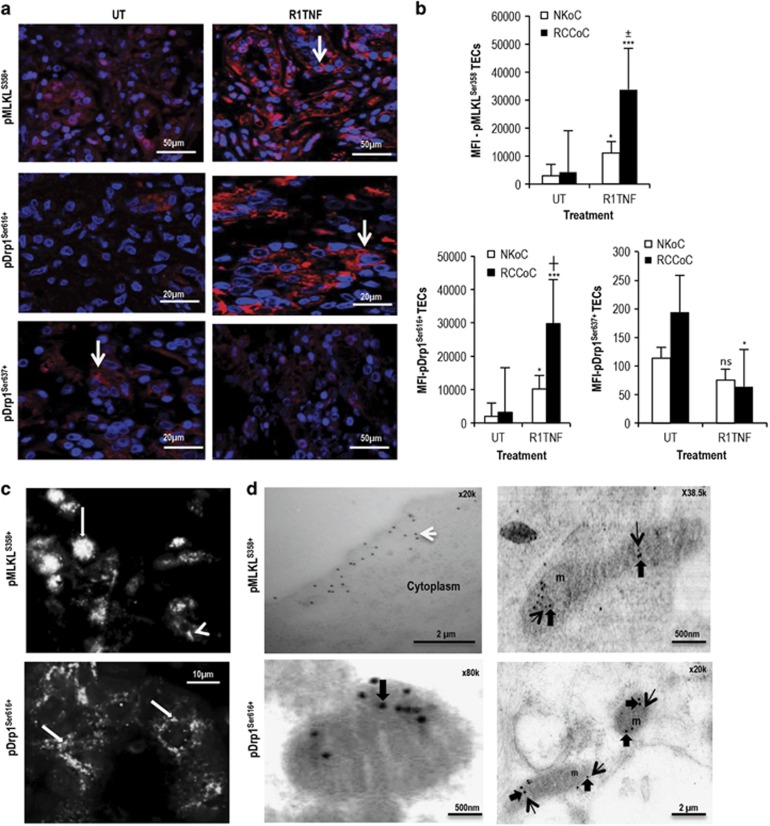
Effect of R1TNF on pMLKLSer358, pDrp1Ser616 and pDrp1Ser637 expression in organ cultures of RCC grade 1 and adjacent non-tumor kidney (NK). (a) R1TNF induced a marked expression of pMLKLS358 and pDrp1Ser616 but a reduced signal for pDrp1Ser637 compared with untreated controls (UT), with signal mainly confined to mTECs (arrows). (b) Quantification of the phosphorylated proteins in normal and mTECs presented as mean fluorescent intensity (MFI) shows a statistical significant difference between cultures. ***P<0.001 versus UT, *P<0.05 versus UT; ±P<0.05 versus R1TNF (NKoC); ┼P<0.001 versus R1TNF (NKoC); ns, not significant. (c) pMLKLSer358 is seen within cytoplasm (arrowhead) and in some nuclei (arrow) (upper panel), while pDrp1Ser616 show cytoplasmic granular pattern (arrows) (lower panel). (d) Immunogold electron microscopy revealed pMLKLSer358 (15 nm particles) on the cell surface (black arrows), within cytoplasm (white arrow) and in mitochondria (m), while pDrp1Ser616 (5 nm particles, black arrow) was mainly confined to mitochondria (m) (open arrows). Bars=mean±S.E.M.; n=3 independent experiments from six separate organ culture experiments with similar results